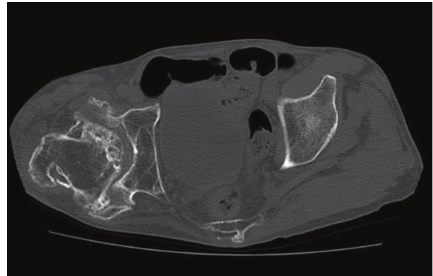
Figure 2: CT imaging around the hip showing marked gluteus muscle atrophy.